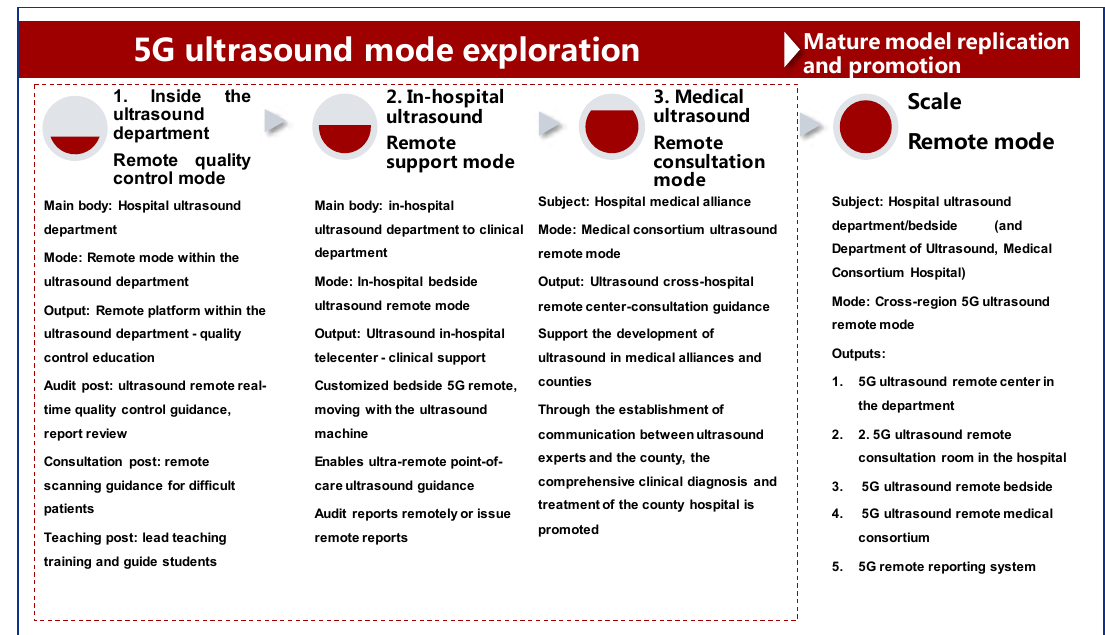
Figure 3 The phased construction of 5G and AI-integrated remote laboratories within and outside the hospitals.